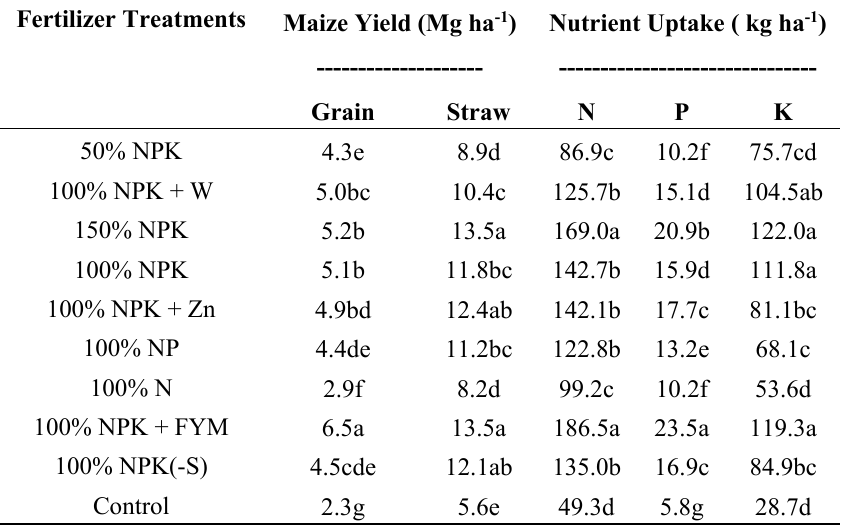
Table 4. Maize yield and nutrient uptake as affected by long-term use of organic and inorganic fertilizers in 2007.